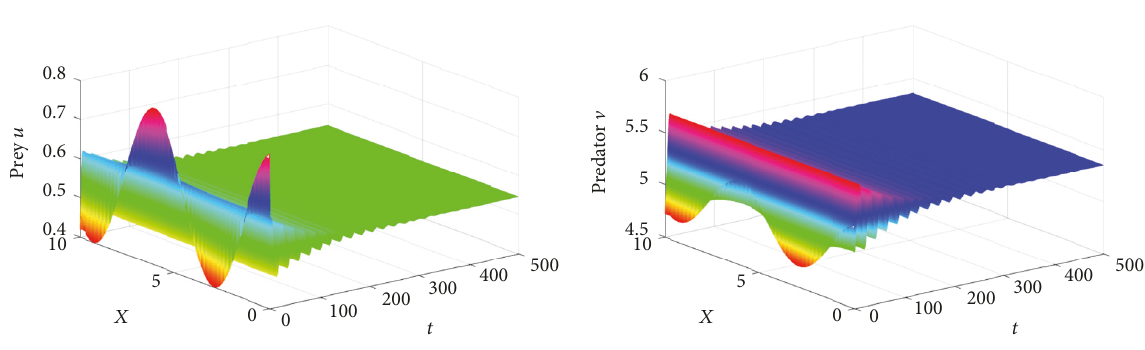
Figure 2: The positive steady state 𝐸 ∗ is locally asymptotically stable.